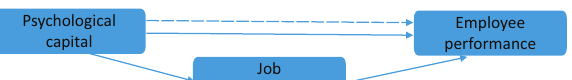
Job satisfaction